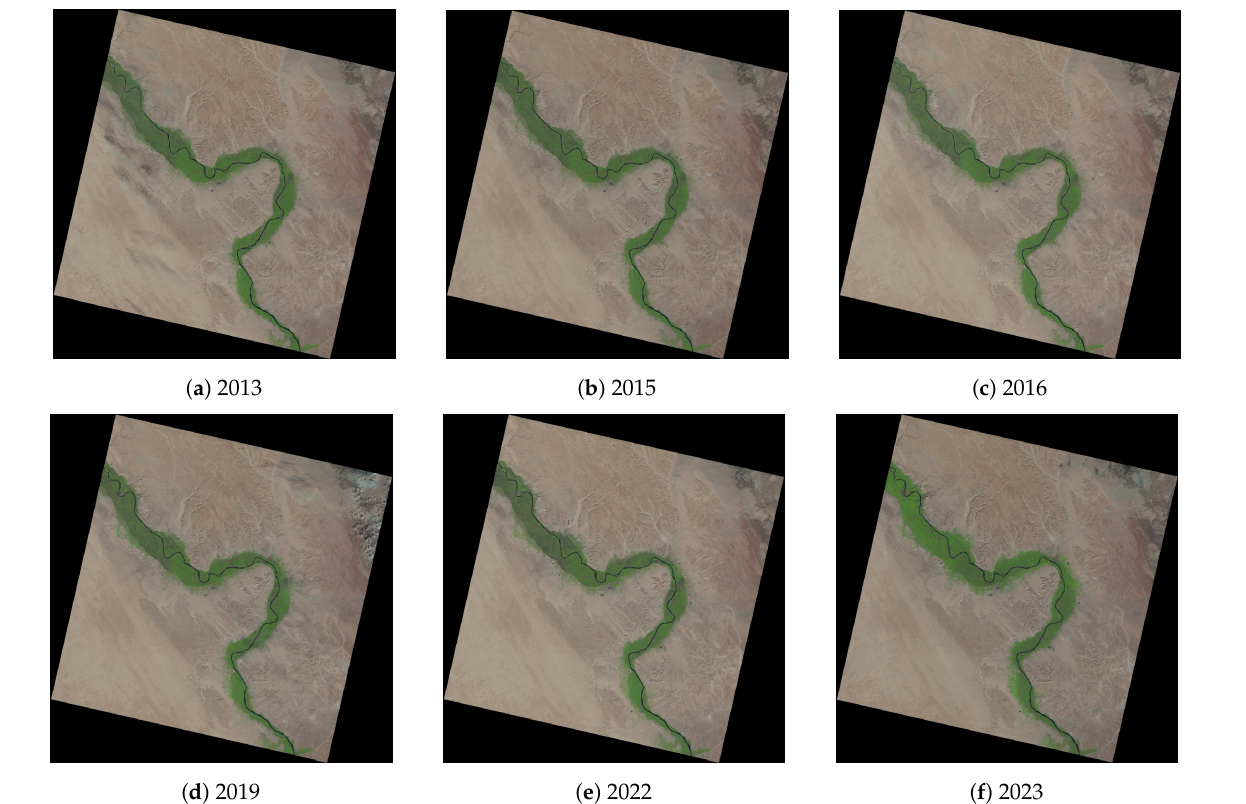
Figure 5. Qena Bend of the Nile River, Egypt, visible on Landsat 8-9 OLI/TIRS images in natu- ral RGB color for six years: ( a ) 16 November 2013, ( b ) 22 November 2015, ( c ) 8 November 2016, ( d ) 17 November 2019, ( e ) 9 November 2022, ( f ) 20 January